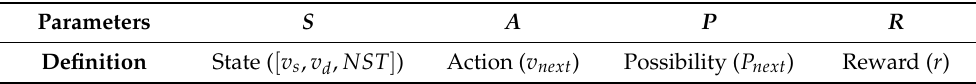
Table 3. The model of the agent in routing strategy based on reinforcement